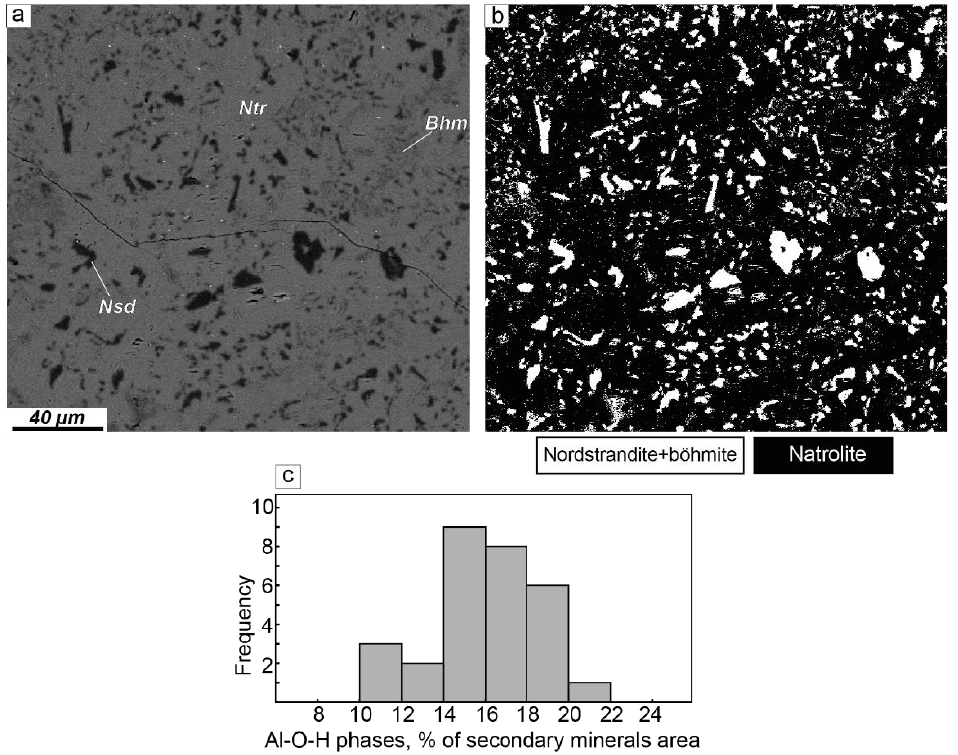
Figure 7. Measurement of areas occupied by nepheline alteration products. ( a ) BSE image of nepheline alteration products (sample LV-335/4); ( b ) binary pattern of Figure 7a, in which black indicates zeolites (82.7% of secondary minerals area), and white indicates nordstrandite + böhmite (17.3% of secondary minerals area); ( c ) bar diagram showing the frequency of samples with different areas occupied by Al-O-H phases. Table 7. Results of measurements of areas occupied by nepheline alteration